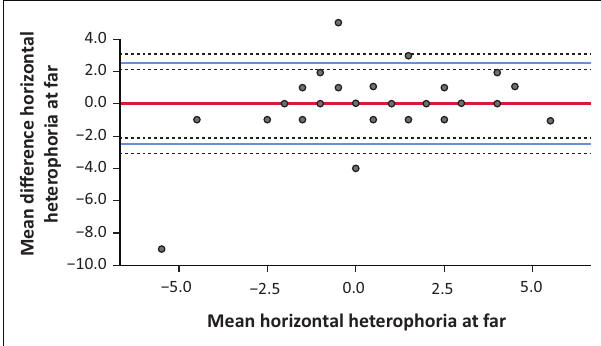
Note: Units are in prism dioptres. Std. Dev., standard deviation. FIGURE 5: Histograms for near vertical heterophoria using (a) the phoropter and (b) trial frame.